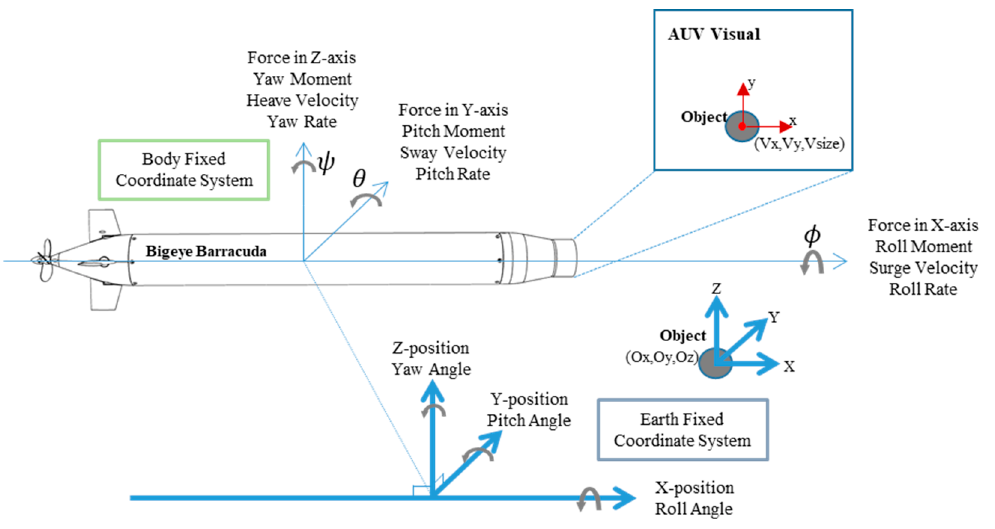
Figure 14. Visual-recognition display from Bigeye Barracuda and object information.